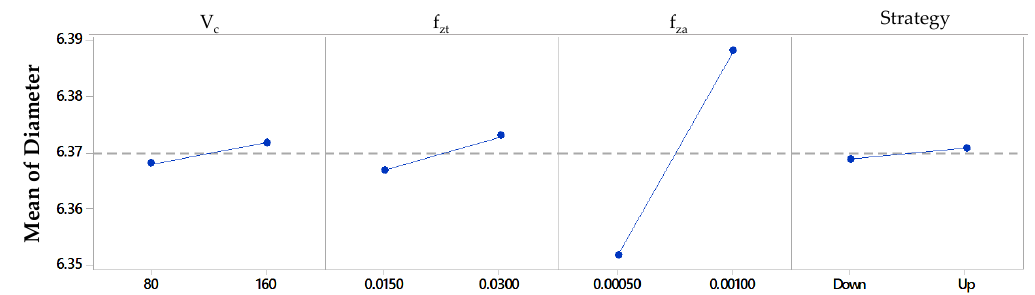
Figure 13. Effects plot for diameter. Figure 13. E ff ects plot for diameter.